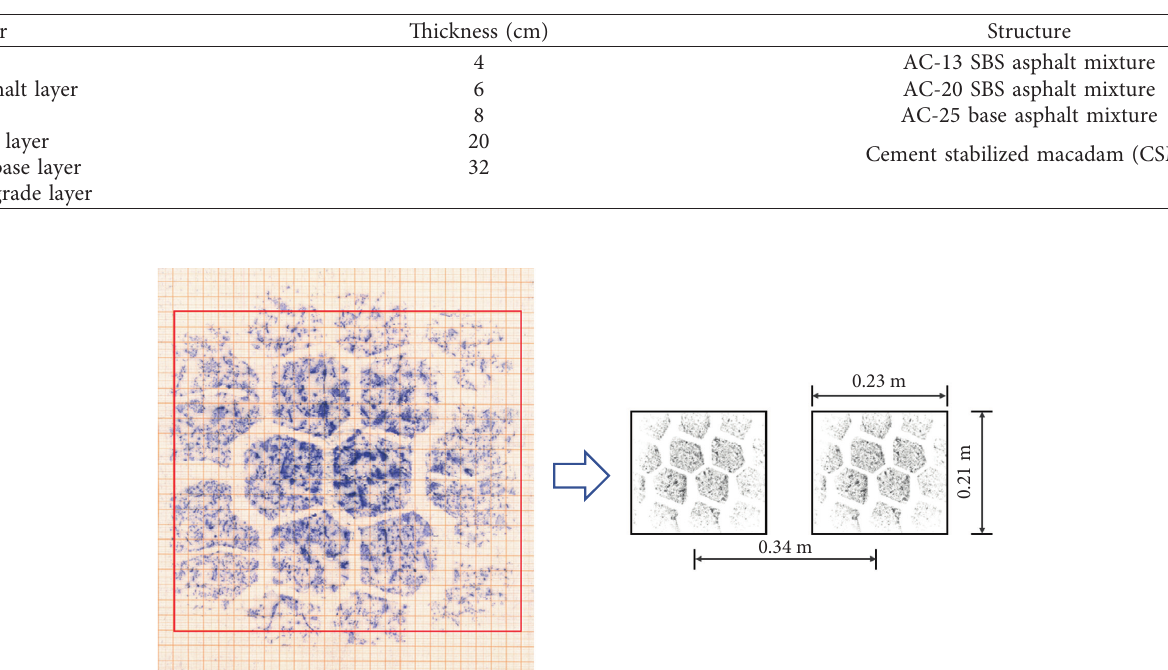
Table 1: Pavement structure.